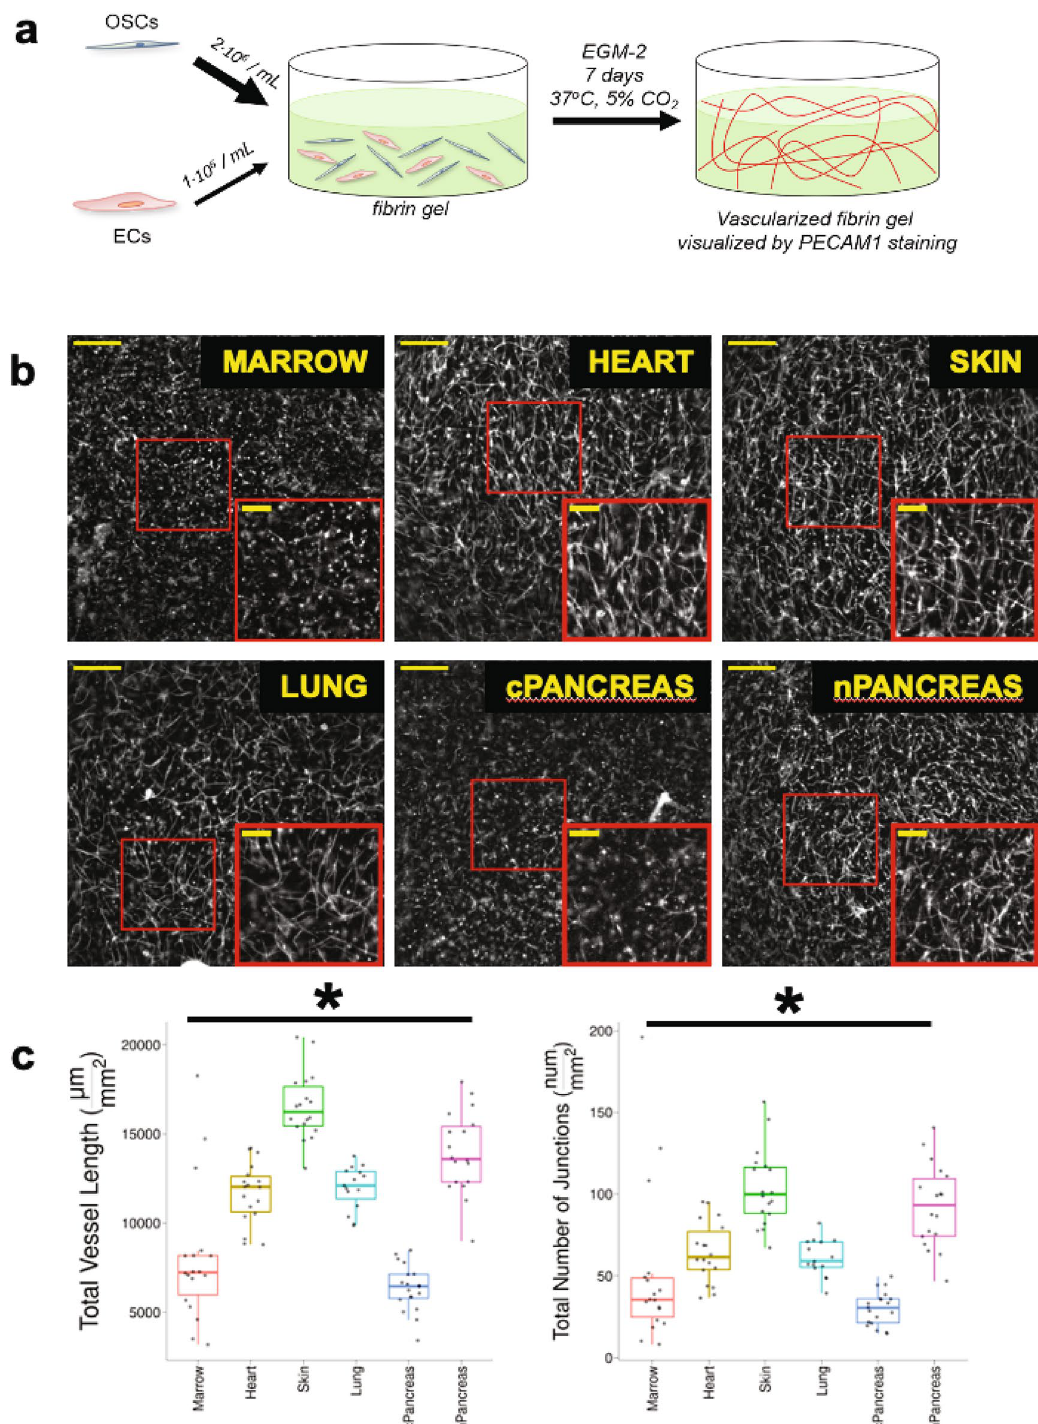
Figure 1. ECs form into CD31 + microvessel networks after 7 days of co-culture with a variety of OSCs in 3D fibrin hydrogels. ( a ) Schematic detailing formation of 3D in vitro fibrin hydrogels and development of microvessel networks. ( b ) Representative images of CD31 + microvessel networks formed using same parental ECFC-EC monolayer and OSCs indicated in each image. Larger image (lower magnification) scale bar represents 500 µm. Inset image is zoomed in image of red-outlined region in lower magnification image and has inset scale bar representing 200 µm. ( c ) Quantification of CD31 + microvessel networks by Angiotool. Total vessel length and total number of junctions normalized by total image area. * p < 0.05 by One-Way